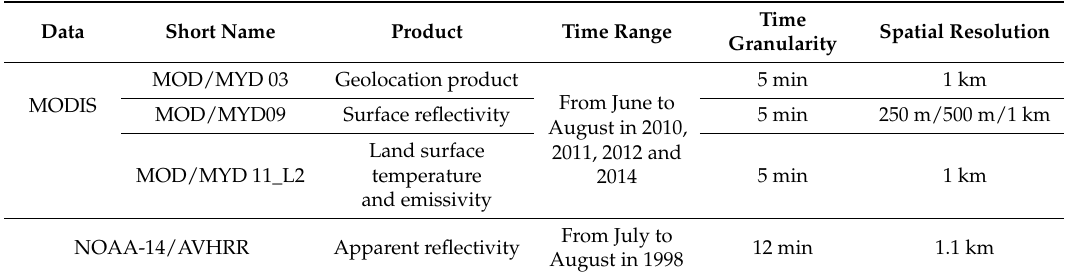
Table 2. Specifications of remote sensing